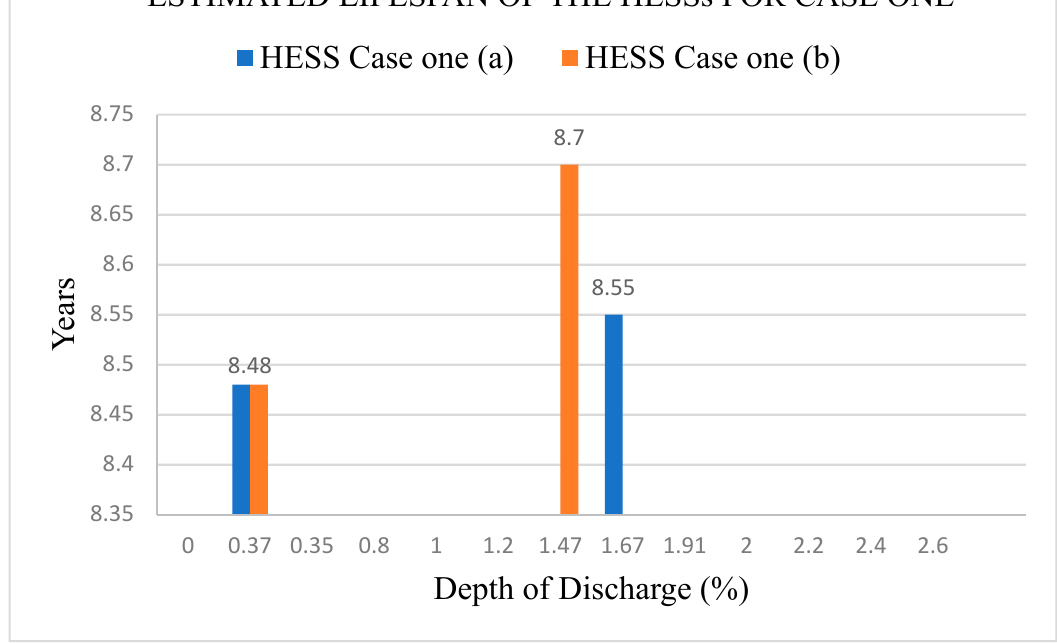
Table 8. Results summary of the proposed HESS.